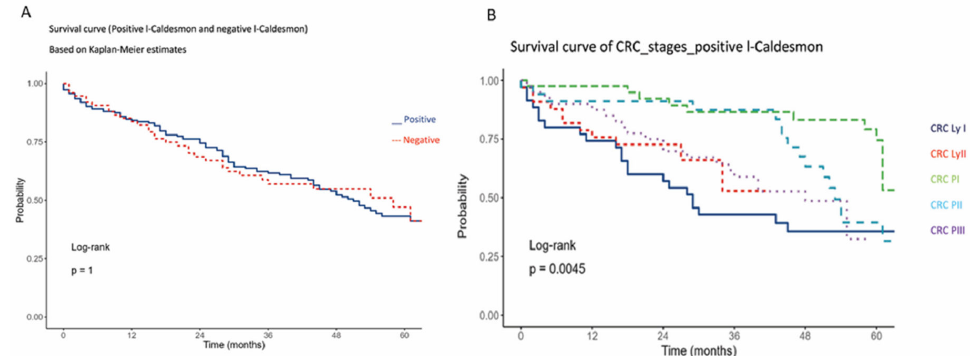
Figure 3. Kaplan–Meier 5-year overall survival analysis of colorectal cancer cases in relation to l-CaD ( A ) and Kaplan–Meier 5-year overall survival analysis of colorectal cancer cases in relation to tumor stage ( B ).